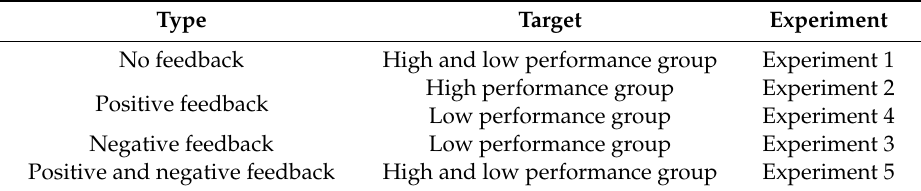
Table 6. ABM experiment